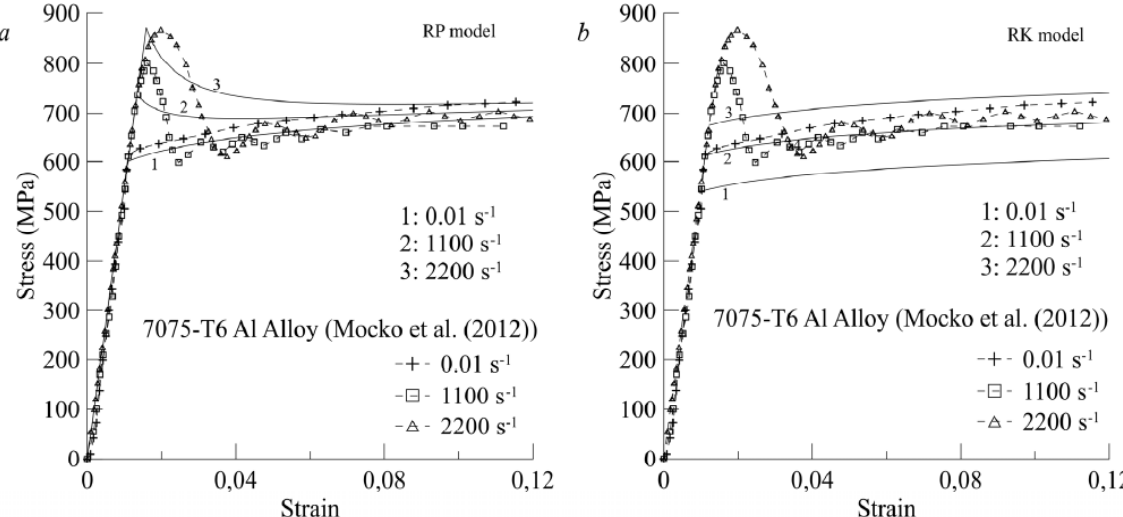
Fig. 9 . Stress-strain relationships of aluminum alloy 7075-T6 (data from [48]), plotted by RP model (a) and RK model (b).